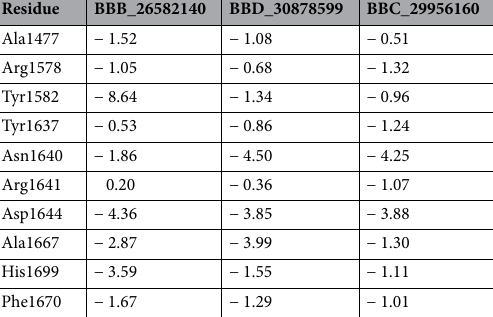
Table 2. Binding energy score of hotspot residues involved in compounds